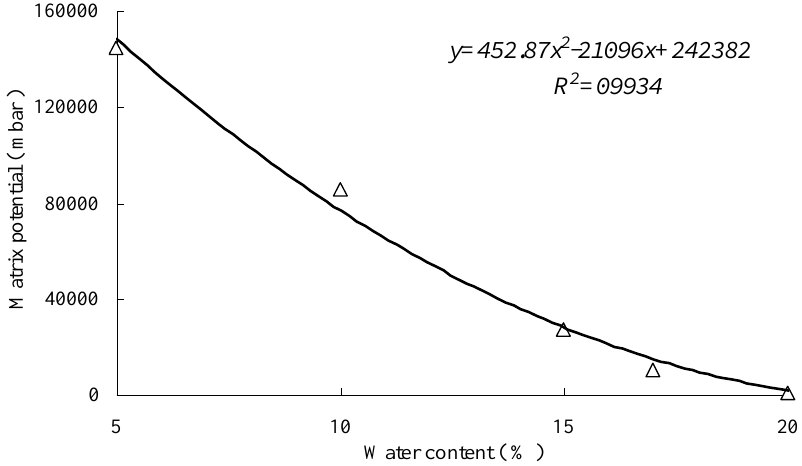
Figure 3. Standard curve for the relationship between matrix potential and water content in